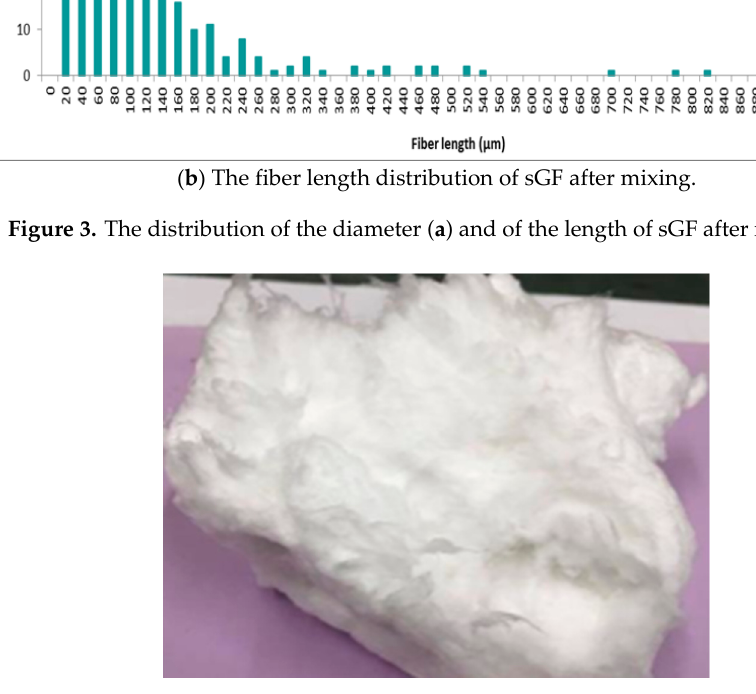
Figure 4. Image of original sGF before mixing with resin.